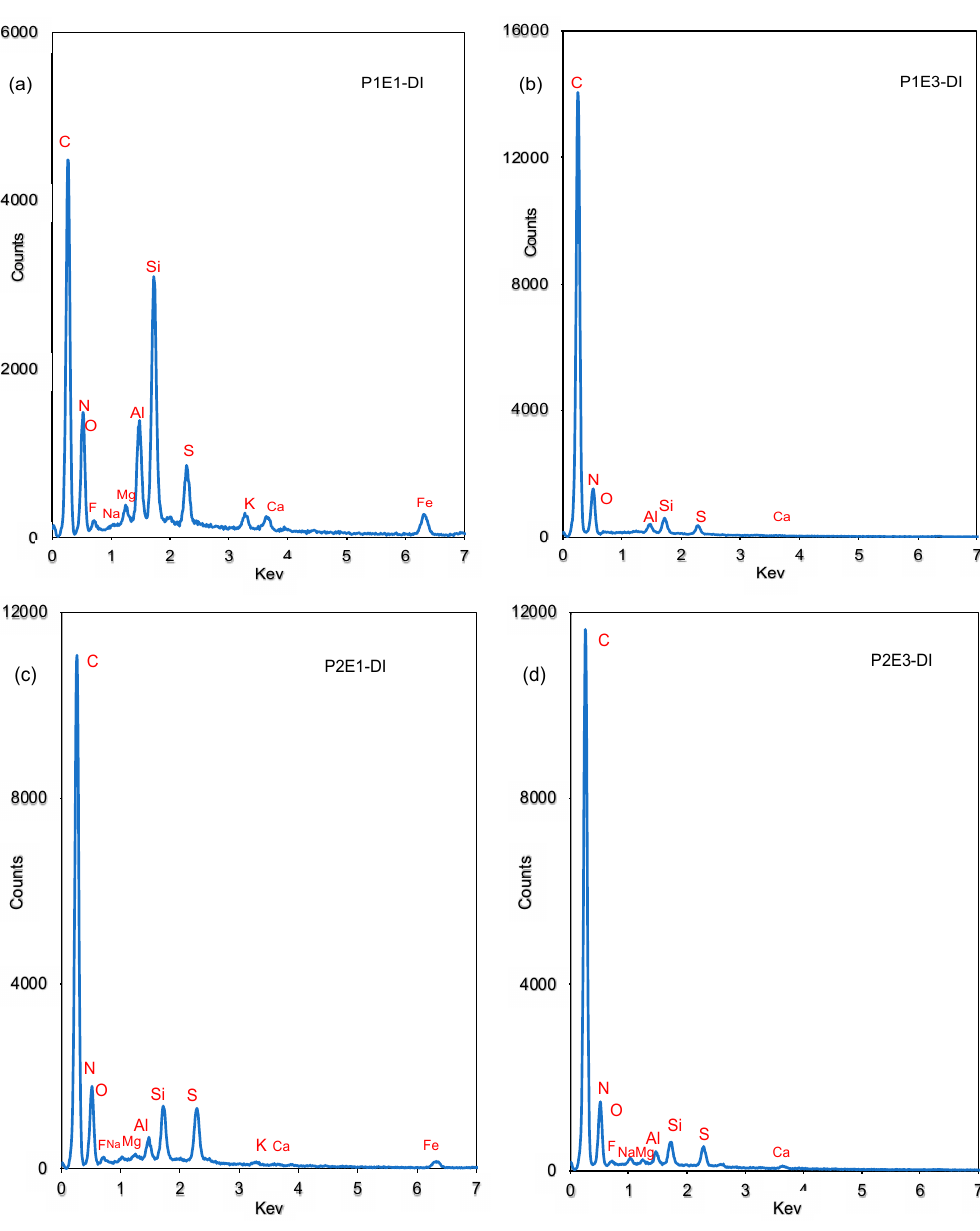
Figure 7. Energy dispersive X-ray microanalysis (EDX) of deionized water rinsed RO membranes. ( a ), Phase 1 Element 1, DI water rinsed (P1E1-DI); ( b ), Phase 1 Element 3, DI water rinsed (P1E3-DI); ( c ), Phase 2 Element 1, DI water rinsed (P2E1-DI); ( d ), Phase 2 Element 3, DI water rinsed (P2E3-DI).